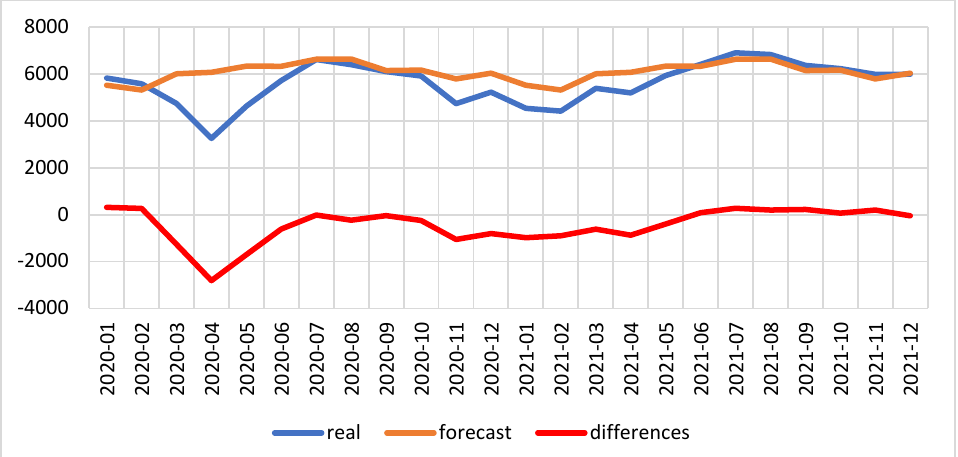
Figure 10. Changes in the volume of motor gasoline supplies to EU countries (in thousand tonnes). Source: own elaboration.